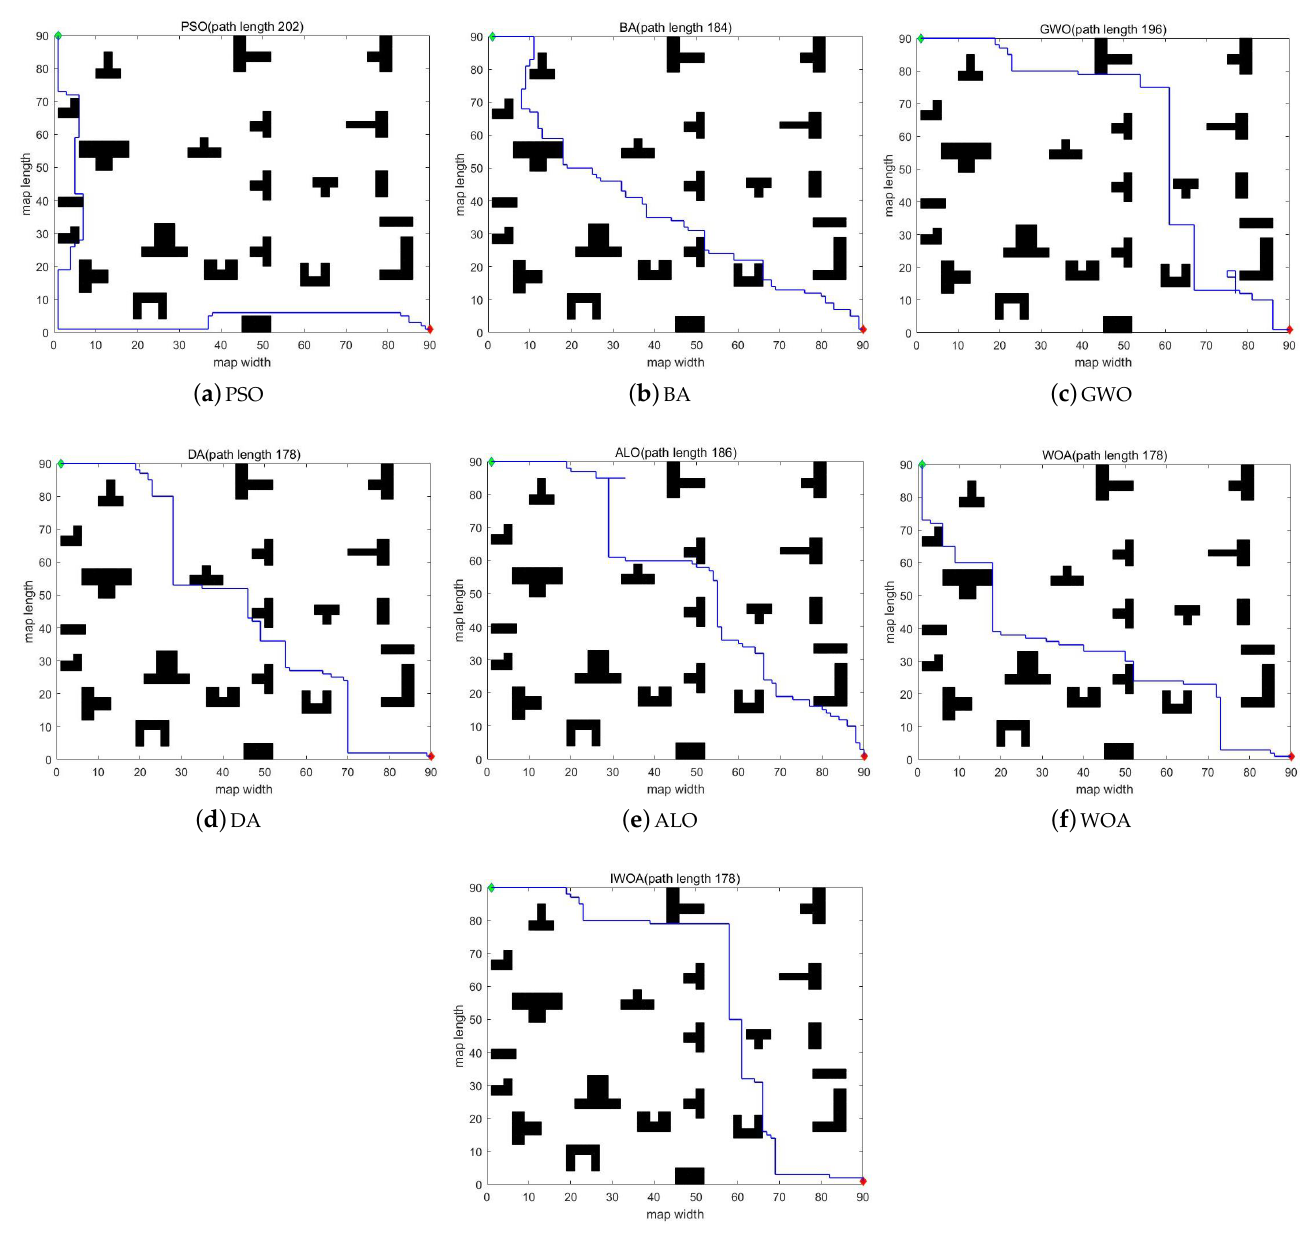
Figure 19. Actual path traces of seven different algorithms on 90 × 90 size